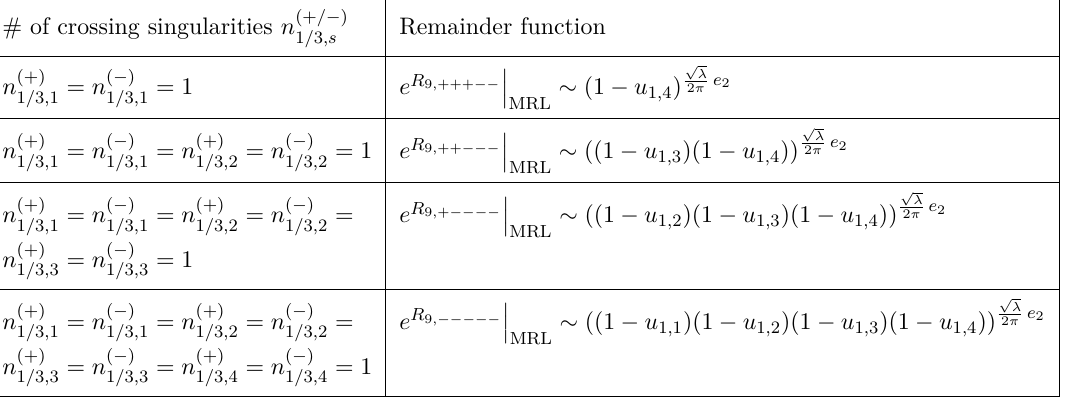
Table 2 . The different types of Regge cuts due to the two-Reggeon bound states all give rise